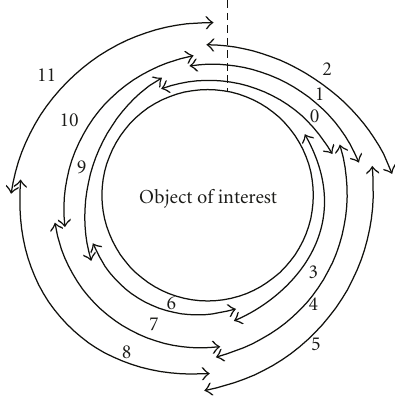
Figure 4: Example of N mod ρ min =